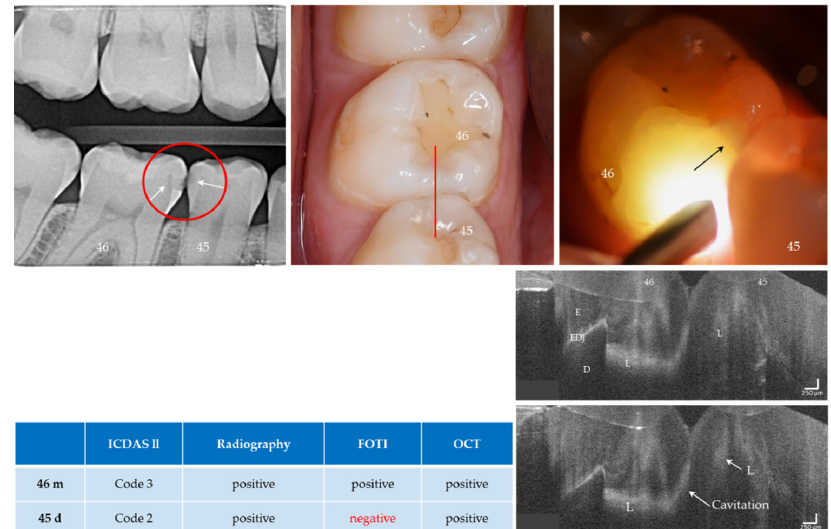
Figure 11. Teeth 46 (m) and 45 (d). Both surfaces showed visual and radiographic caries lesions (L, arrows) and dentin involvement was visible on tooth 46. The FOTI showed no signal on tooth 45 distally (arrow indicates the lesion of tooth 46), while a weak signal was visible on OCT. In the OCT images of tooth 46, dentin involvement is clearly visible and cavitation can be assumed due to the diagonal signal line (see Fig. 5b) and the anatomy of the tooth surface. Verification : Both the early carious lesion on tooth 45 and the cavitated lesion on tooth 46 could be confirmed later during the restoration of tooth 46. Enamel (E), dentin (D), enamel ‐ dentin junction (EDJ). The vertical scales are related to refractive index n = 1.5 .